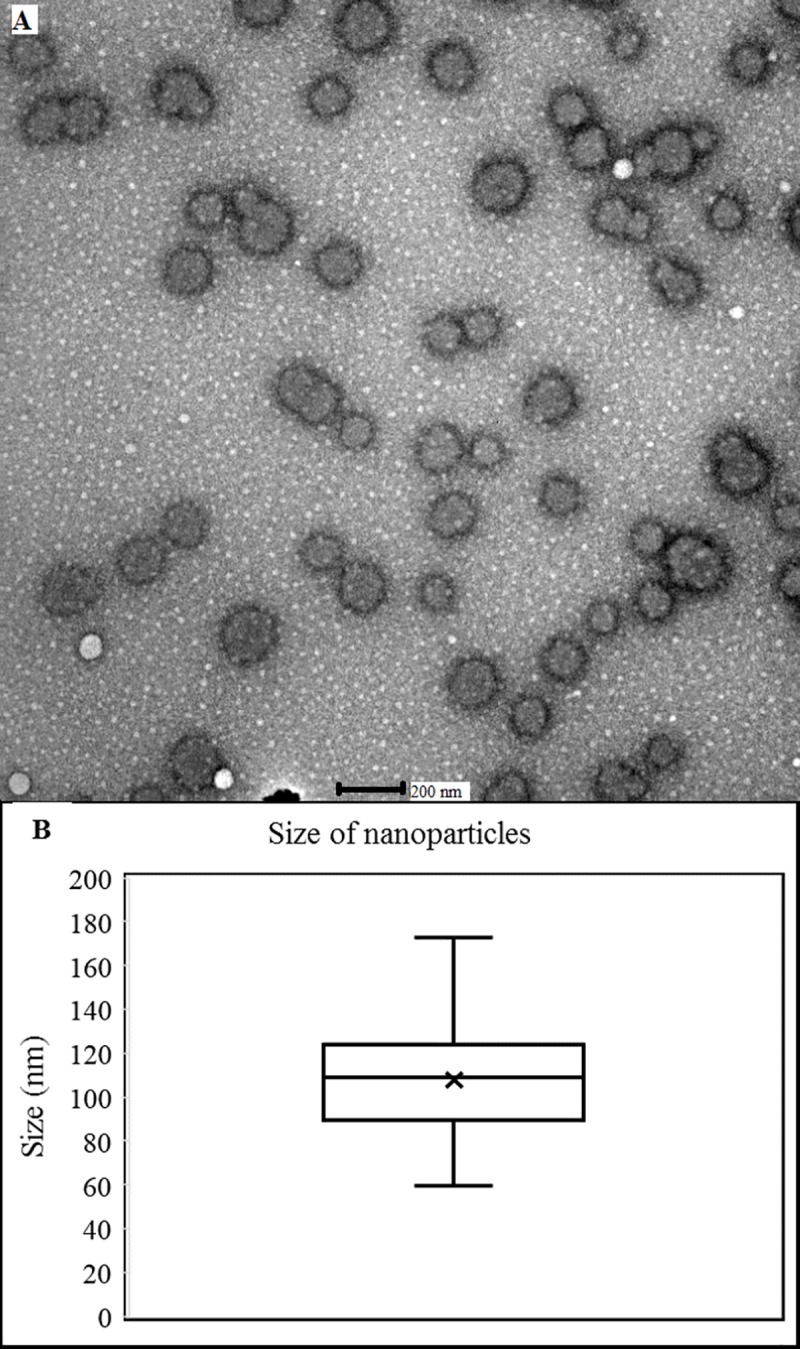
Transmission electron microscopy of chitosan-propolis nanoparticles.A) Chitosan-propolis nanoparticles from formulation F1 were stained with uranyl acetate and examined by transmission electron microscopy to determine the average particle size. B) Box plot depicting the average size of the nanoparticles calculated using ImageJ software.